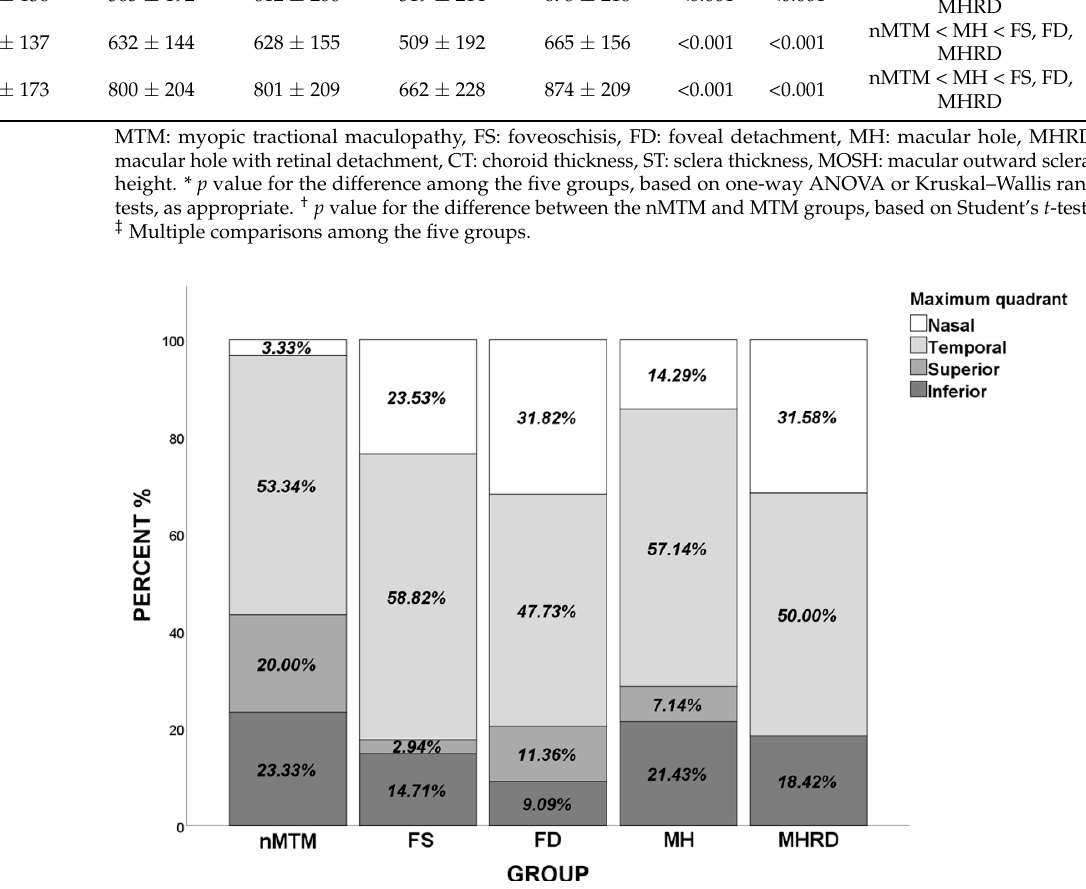
Figure 3. Distribution of the maximum MOSH, located in different quadrants in different grades of MTM. MTM: myopic tractional maculopathy, FS: foveoschisis, FD: foveal detachment, MH: macular hole, MHRD: macular hole with retinal detachment.